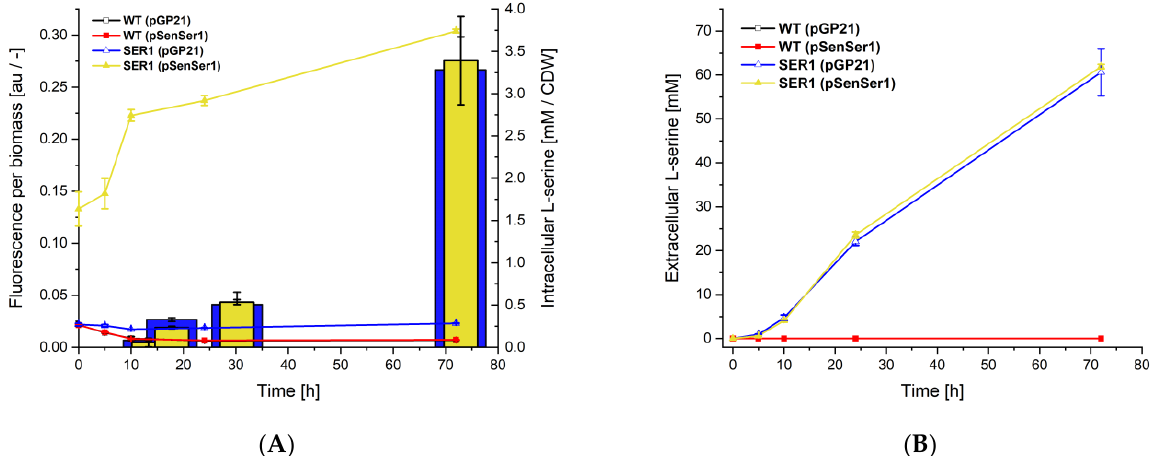
Figure 2. Characterization of L -serine biosensor plasmid pSenSer1 in the C. glutamicum ATCC 13032 (WT; square) and the recombinant L -serine producer strain SER1 (triangle). WT and SER1 were transformed with either empty vector pGP21 (empty symbols) or pSenSer1 (filled symbols). The seed cultures were first grown in CGXII minimal medium without folate to induce folate starvation before cultivating in the main culture using CGXII minimal medium supplemented with 0.1 mM folate. ( A ) The y-axis on the left shows mVenus fluorescence signal normalized to the biomass (backscatter measured in the BioLector; lines). The y-axis on the right shows intracellular L -serine concentrations (bars) determined at 5 h, 10 h, 24 h, and 72 h. ( B ) Extracellular L -serine concentrations were measured at cultivation time points when intracellular concentrations were measured. Means and errors of three cultures are presented.